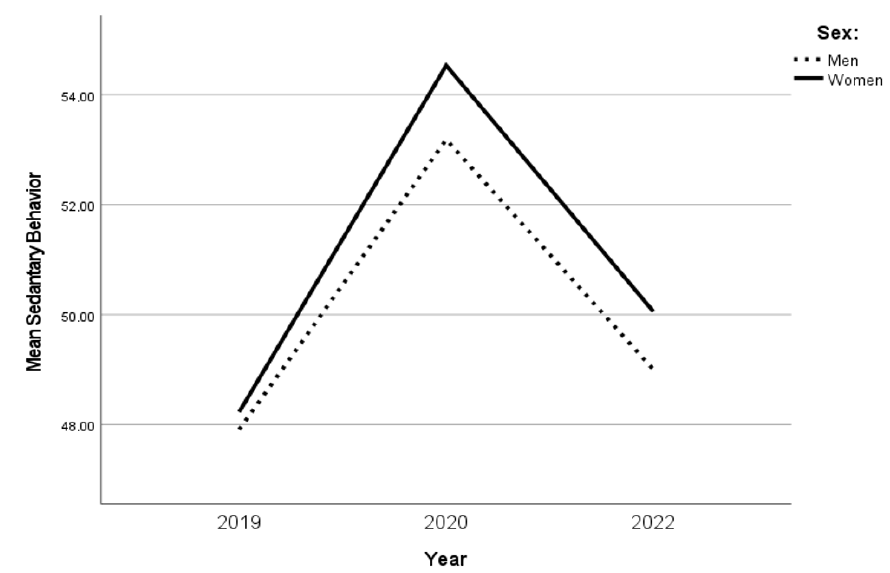
Figure 3. The changes in SB in sexes over time.